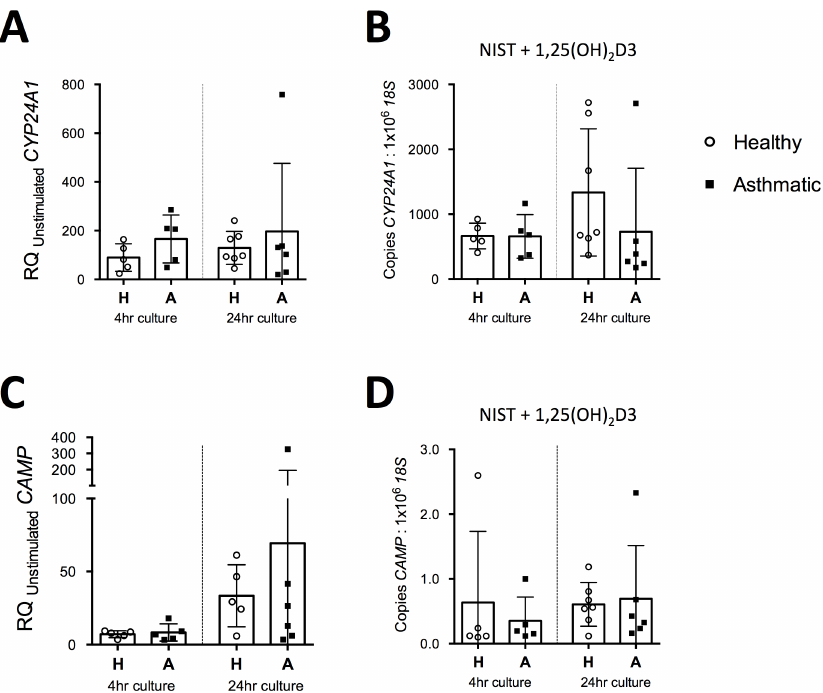
Fig 4. Comparison of expression of vitamin D axis genes between HBECs from healthy and asthmatic donors. (A) Induction of CYP24A1 by NIST with 100nM 1,25(OH) 2 D3, relative to the unstimulated control condition, in 4 hour and 24 hour HBEC cultures. H, Healthy donor HBECs; A, Asthmatic donor HBEC cultures. 4hr healthy, n = 5; 4hr asthmatic, n = 5; 24hr healthy, n = 7; 24hr asthmatic, n = 6.(B) Expression of CYP24A1 as measured by qPCR relative to 18S in 4 hour and 24 hour HBEC cultures stimulated with 50 μ g/ml NIST and 100nM 1,25(OH) 2 D3. 4hr healthy, n = 5; 4hr asthmatic, n = 5; 24hr healthy, n = 7–8; 24hr asthmatic, n = 6. (C) Induction of CAMP by NIST with 100nM 1,25(OH) 2 D3, relative to the unstimulated control condition, in 4 hour and 24 hour HBEC cultures. 4hr healthy, n = 5; 4hr asthmatic, n = 5; 24hr healthy, n = 5; 24hr asthmatic, n = 6. (D) Expression of CAMP as measured by qPCR relative to 18S in 4 hour and 24 hour HBEC cultures stimulated with 50 μ g/ml NIST and 100nM 1,25(OH) 2 D3. 4hr healthy, n = 5; 4hr asthmatic, n = 5; 24hr healthy, n = 7; 24hr asthmatic, n = 6.